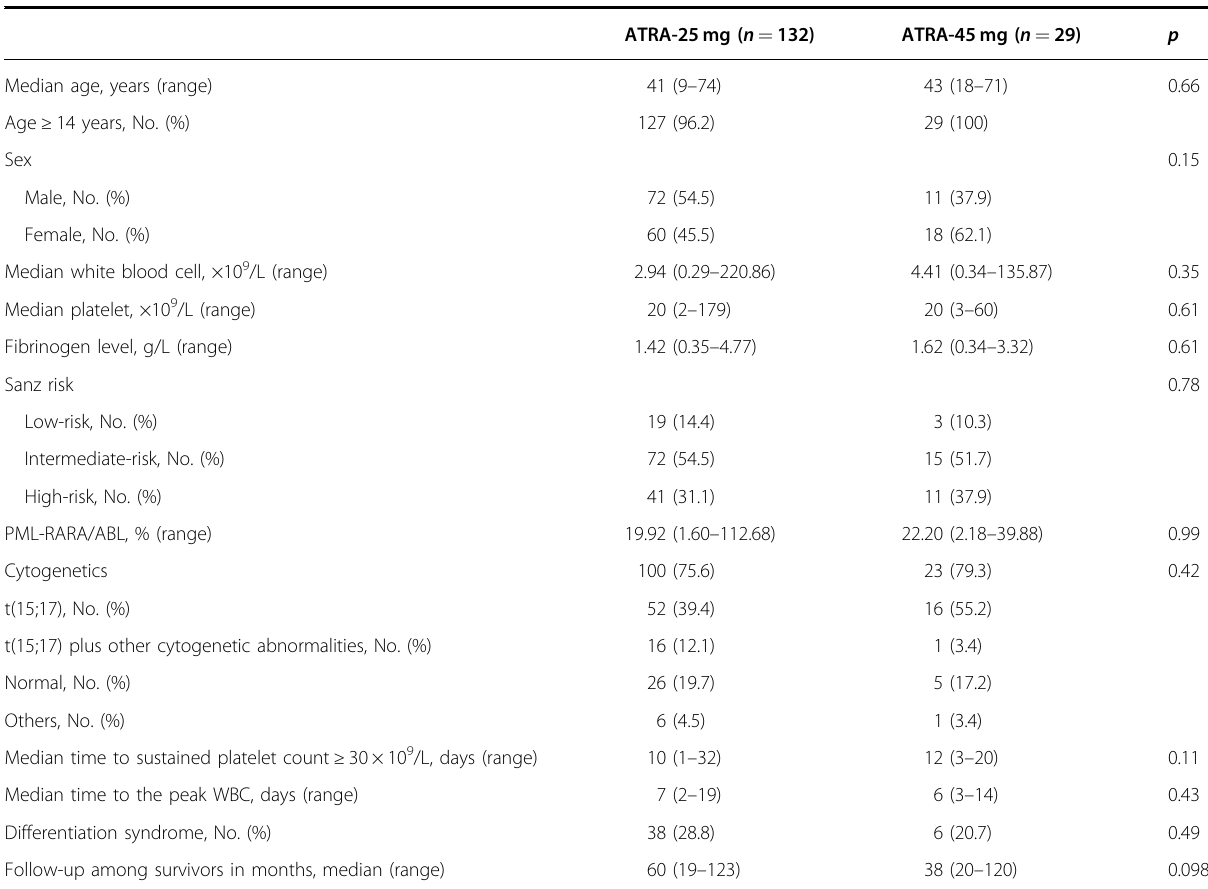
Table 1 Clinical